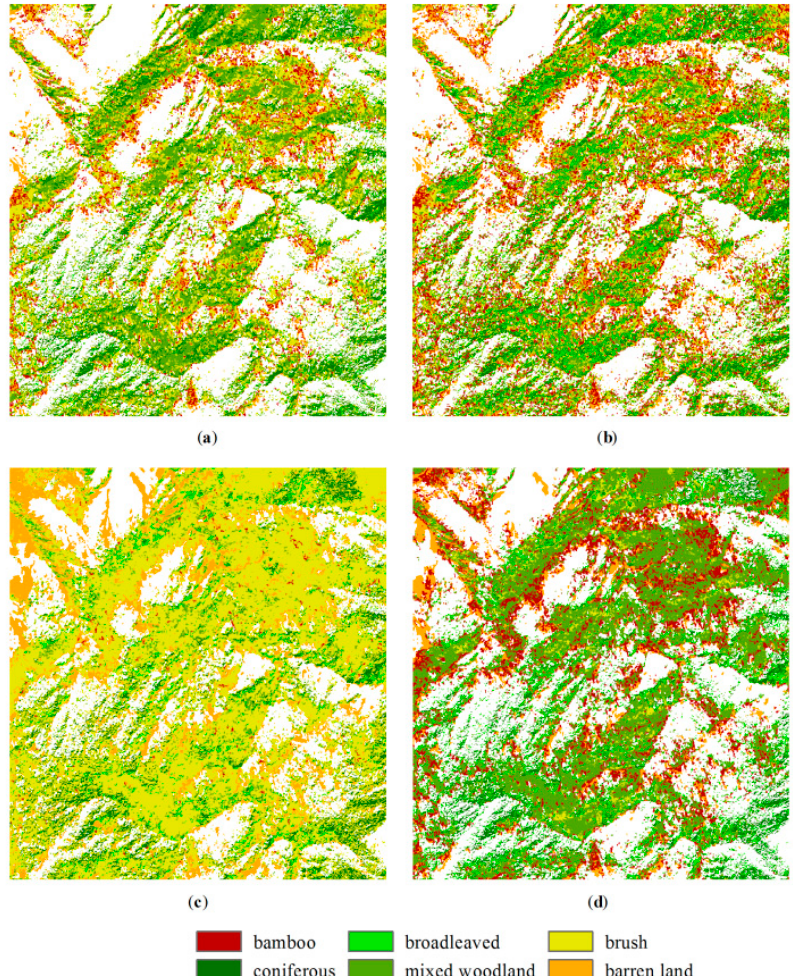
Figure 9. Classified maps generated using ( a ) CART; ( b ) k -NN; ( c ) Bayesian and ( d ) SVM methods based on the expanded training data.